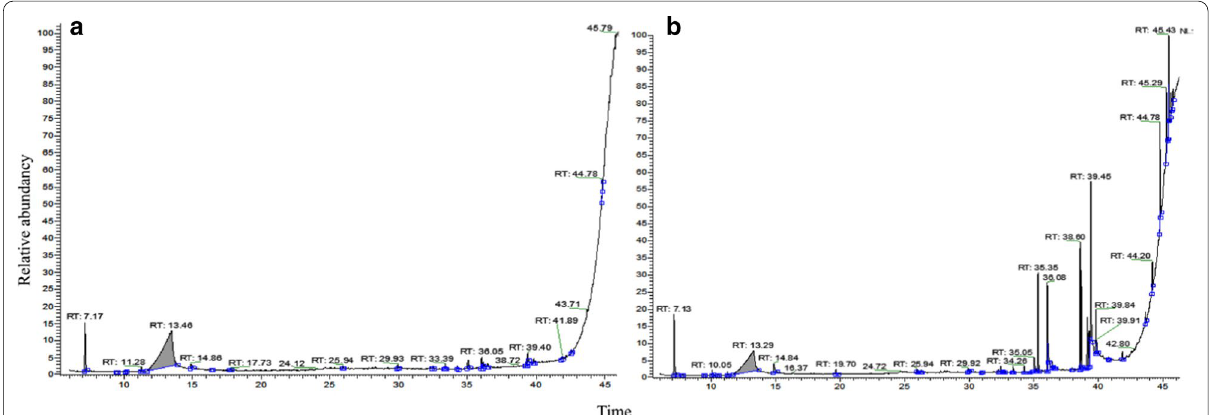
Fig. 3 Chromatograms of the bioactive compounds present in a hot, and b cold acetone extracts of madhuca cake